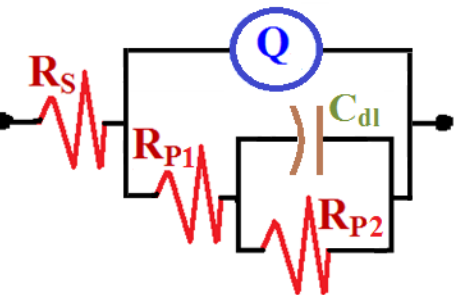
Figure 11. Nyquist plots of fabricated ODS-HECs for (1) CrFeCuMnNi; (2) CrFeCuMnNi-3 vol.%